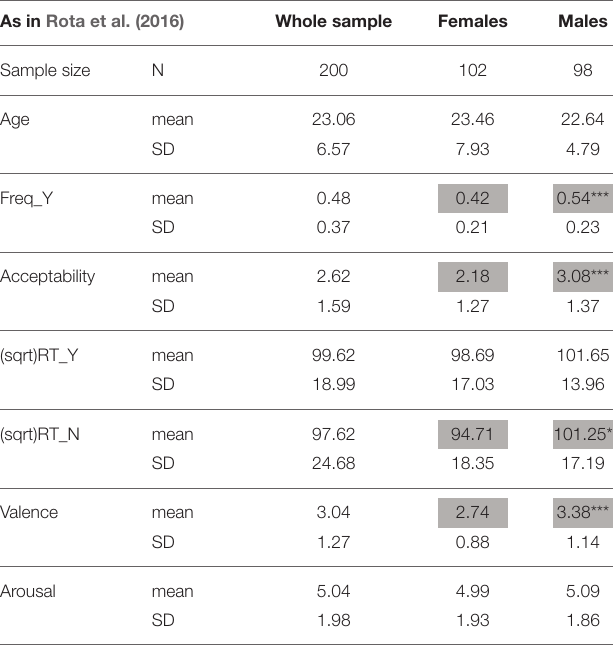
TABLE 2 | Demographic and descriptive data of response variables to moral dilemmas, in the whole sample (males plus females) and in the two separate genders (as reported in Rota et al.,